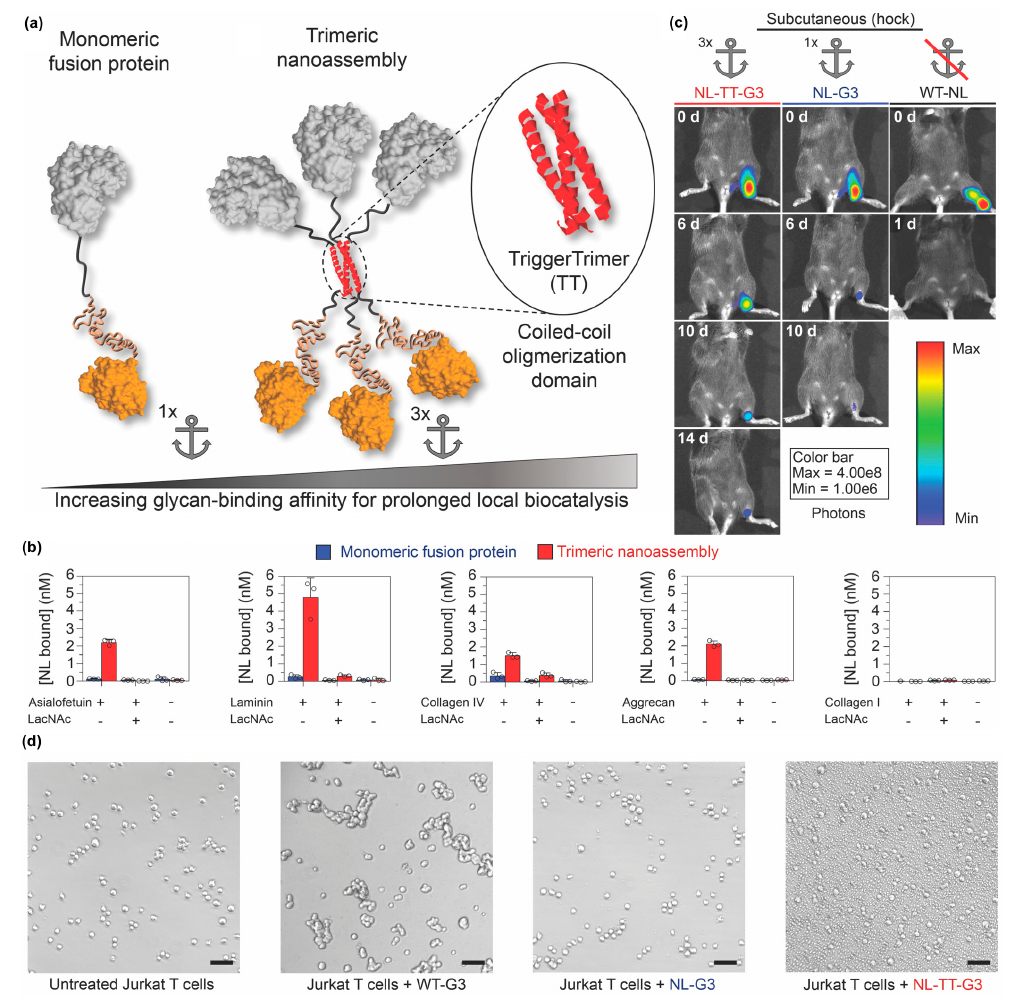
Figure 12. Locally anchoring enzyme nanoassemblies to tissues via Galectin-3. ( a ) Schematic representation of protein nanoassemblies fabricated using peptides that form an α -helical coiled-coil. (Left) A monomeric fusion protein consisting of an enzyme linked to the N-terminal domain of Galectin-3 (G3) via a flexible peptide linker. (Right) Trimeric nanoassembly formed by inserting the TriggerTrimer α -helical coiled-coil domain between the enzyme and G3 domains. The trimeric